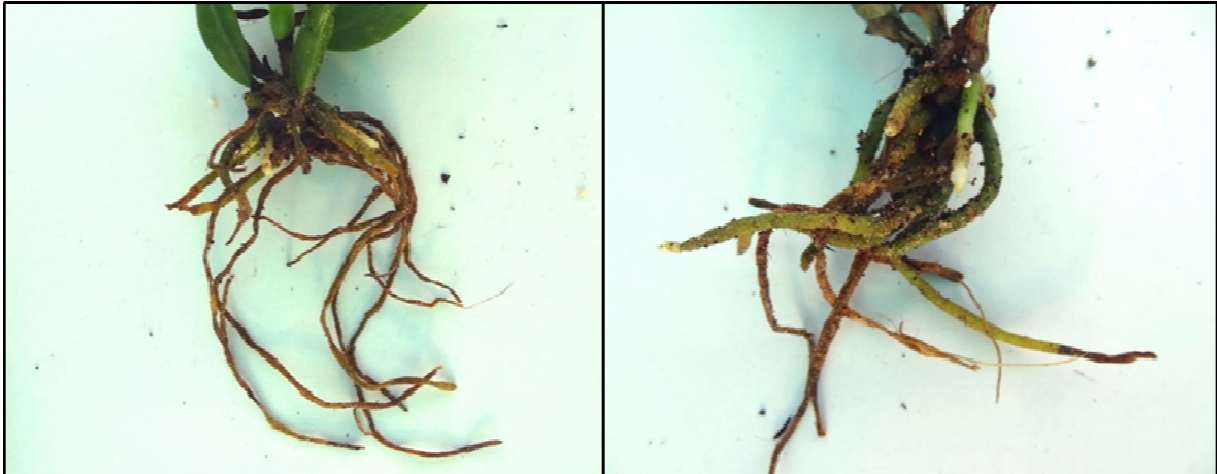
Fig. 4. Dying-off of in vitro poorly developed roots (left) and survival of in vitro well developed roots (right) of orchid plantlets during acclimatization stage in net house Table 3. Effect of NAA and IBA (mg l -1 ) on different growth parameter of orchid plantlets under net house conditions